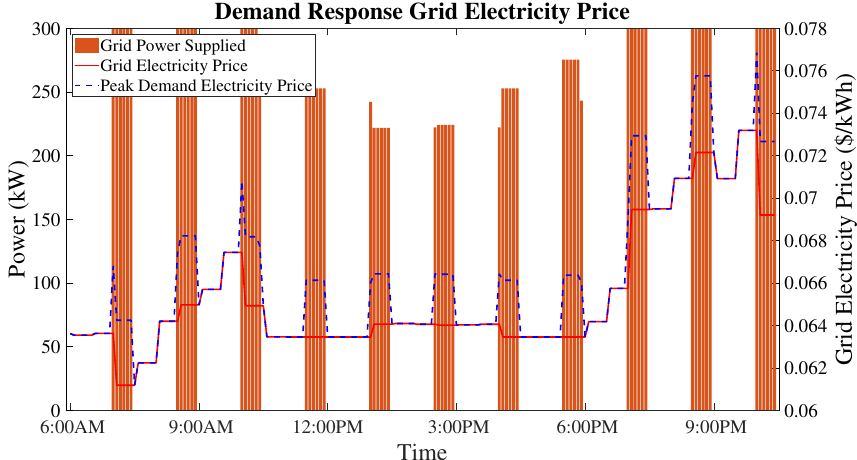
Figure 13. Economic dispatch for ferry generation scheduling (case study 2).